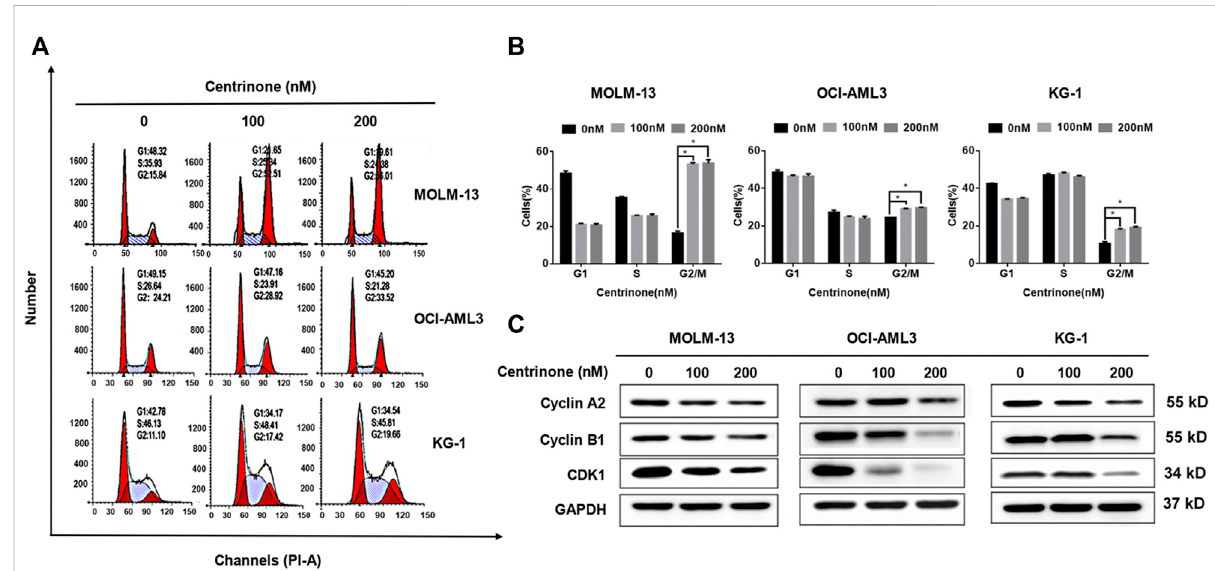
FIGURE 4 Centrinone caused AML cells in the G2/M phase cell cycle arrest by reducing the expression of Cyclin A2, Cyclin B1, and CDK1. (A) AML cells weretreatedbyCentrinonefor48h,andthecellcycleofethanol- fi xedcellswithPIstainingwasanalyzedby fl owcytometry. (B) Statisticalanalysisof the distributionof G1, S and G2/M phase AML cells treated by Centrinone (compared with the control group, * p < 0.05). (C) The expression of Cyclin A2, Cyclin B1, and CDK1 were detected by Western